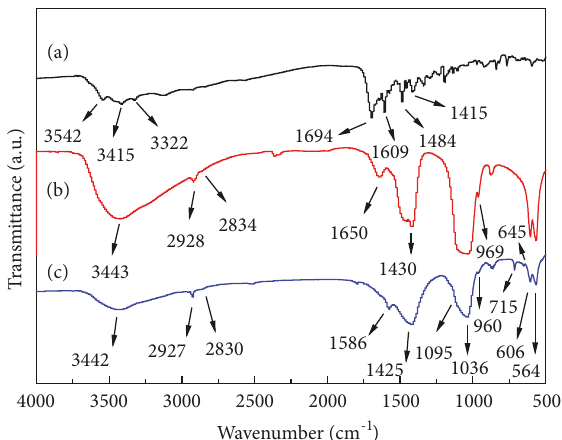
Figure 4: XRD patterns of the samples. (a) FA-grafted hydroxya- patite; (b) aminated hydroxyapatite; (c) hexagonal hydroxyapatite standard card No. 09–0432.